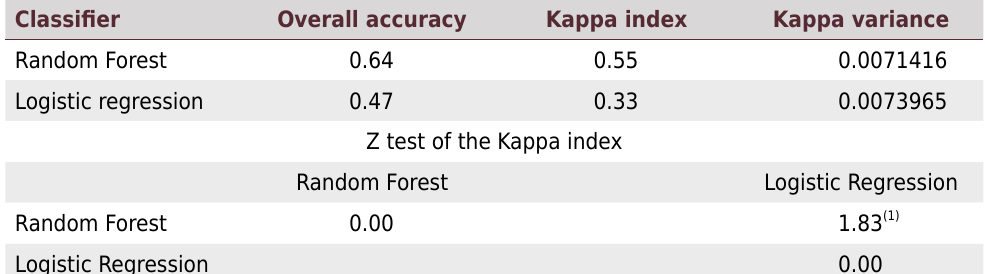
Table 5. Comparison of classification performance by Random Forest and Multinomial Logistic Regression for external